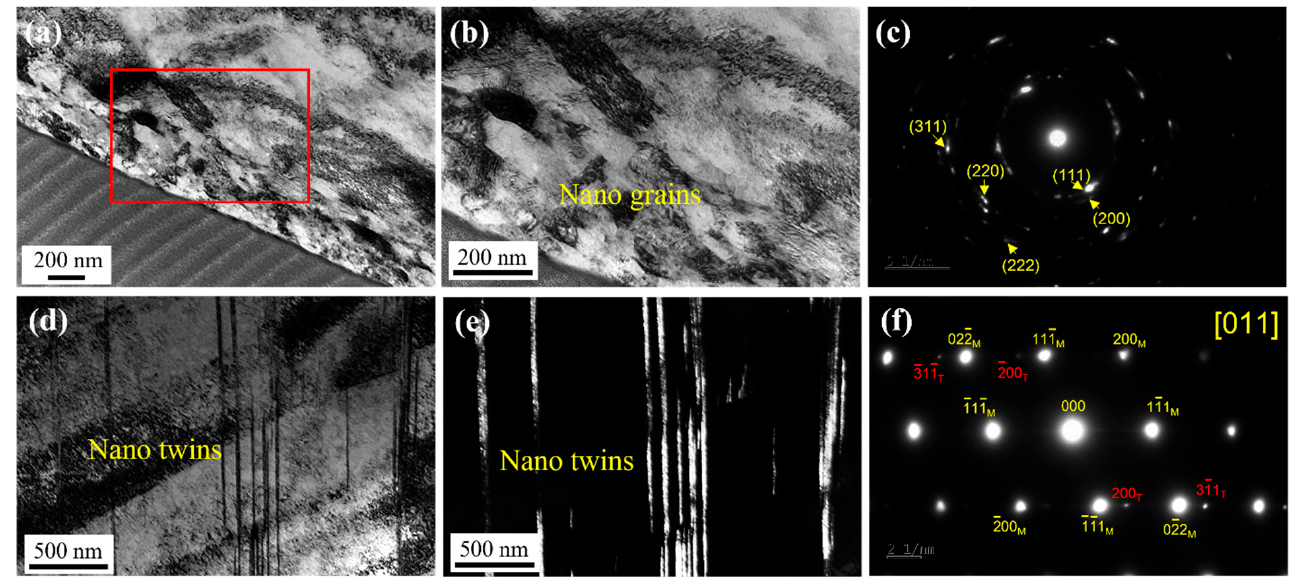
Figure 4. TEM micrographs of regions adjacent to the top surface layer of the SMAT processed condition of the SS 316L specimen and magnified view of a selected locations: ( a ) bright-field image of a nano-grained layer; ( b ) higher magnification micrograph of nanograins in the region marked by the red rectangle in ( a ); ( c ) SAED of nanograins; ( d ) bright-field image showing nanotwins and slip bands, ( e ) dark-field image highlighting the nanotwins; ( f ) SAED of the